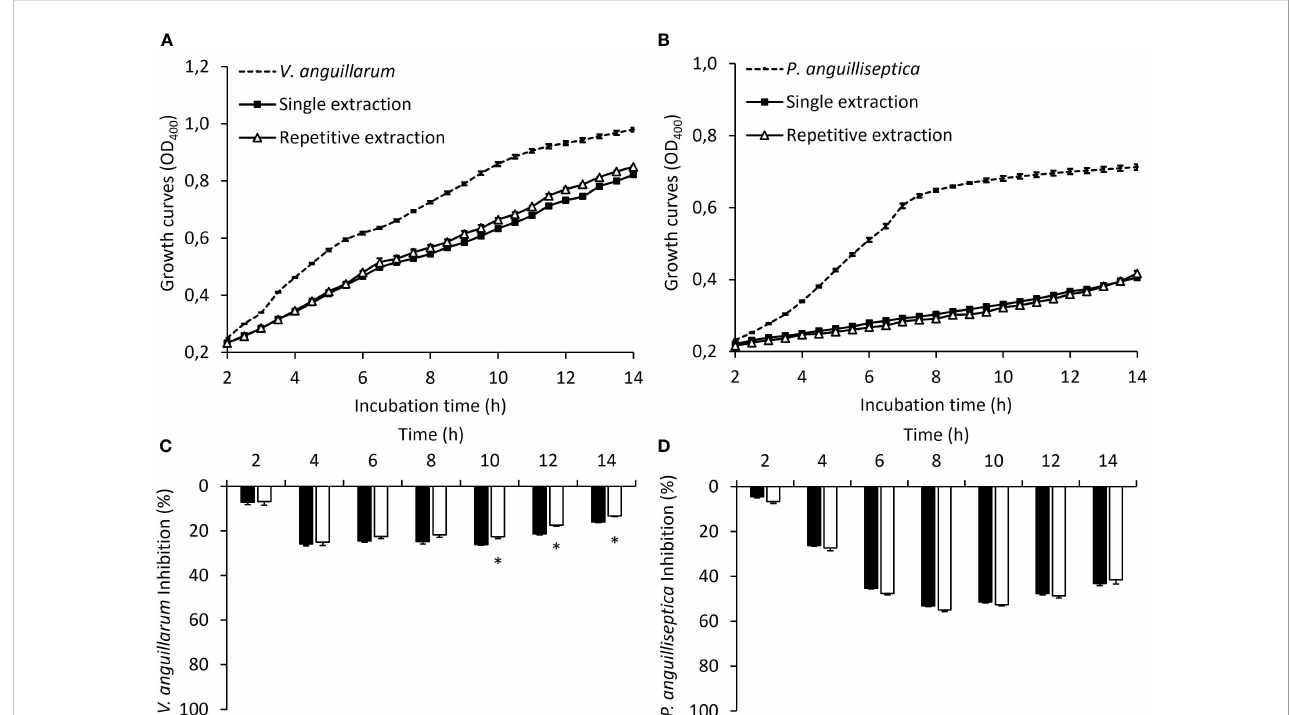
FIGURE 1 The antibacterial properties of juvenile gilthead sea bream skin mucus. Antibacterial activity against V. anguillarum (A) and P. anguilliseptica (B) of skin mucus obtained from a single extraction (SEG; black squares) or after repetitive extractions (REG; white triangles). Dashed lines correspond to the growth of both pathogenic bacteria used as a control. Inhibition rates against V. anguillarum (C) and P. anguilliseptica (D) for the skin mucus obtained from a single extraction (SEG; black bars) or after repetitive extractions (REG; white bars). (*) indicates signi fi cant differences between the single extraction and repetitive extractions (P< 0.05; Student ’ s t -test; N =